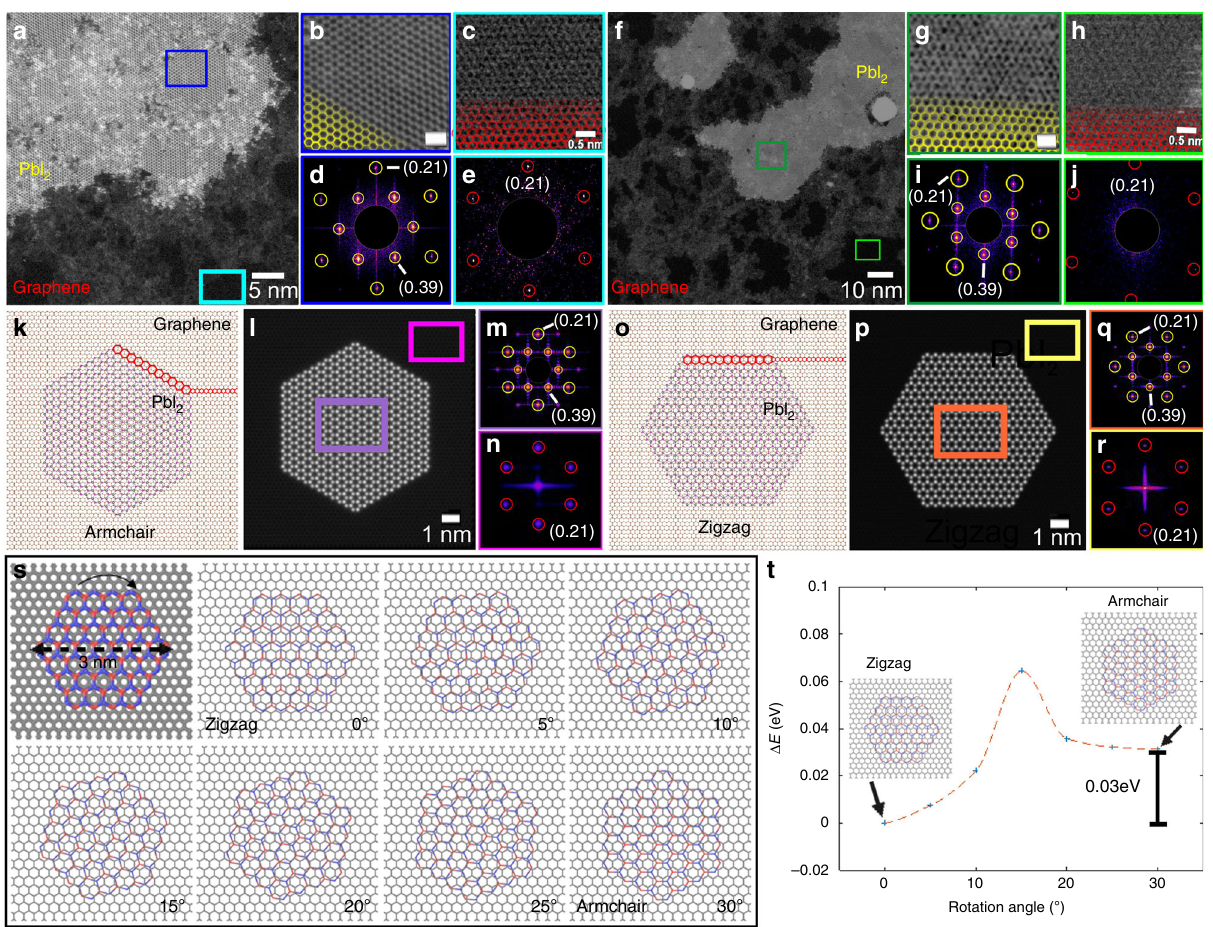
Fig. 3 Crystal orientation of monolayer PbI 2 on graphene. a ADF-STEM images of PbI 2 fl ake suspended on graphene. b High-resolution image of PbI 2 crystal annotated in the dark blue box in a . Scale bar corresponds to 1 nm. c High-resolution image of graphene taken from the cyan box region indicated in a . d FFT of PbI 2 from the region indicated in b . c FFT of graphene from the region indicated in c . f ADF-STEM images of PbI 2 fl ake suspended on graphene. g High-resolution image of PbI 2 crystal indicated by the dark green box in f . Scale bar corresponds to 1 nm. h High-resolution image of graphene from the light green box in f . i FFT of PbI 2 from the region indicated in g . h FFT of graphene from the region indicated in f . k Atomic model of PbI 2 (1 H) on graphene in the armchair direction. l Multislice image simulations based on the atomic model in k . m FFT of PbI 2 from the region indicated by the purple box in l . n FFT of graphene from the region indicated by the pink box in l . o Atomic model of PbI 2 (1 H) on graphene in the armchair direction. p Multislice image simulations based on the atomic model in k . q FFT of PbI 2 from the region indicated by the orange box in p . r FFT of graphene from the region indicated by the yellow box in p . s Atomic models showing PbI 2 relative to graphene for s DFT-relaxed atomic model of PbI 2 on graphene, rotated every 5 degrees. t Energy pro fi le of various orientation angles of the PbI 2 fl ake on